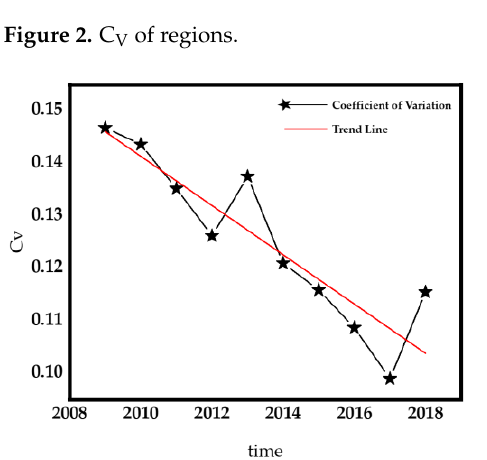
Figure 3. C V of the time dimension.